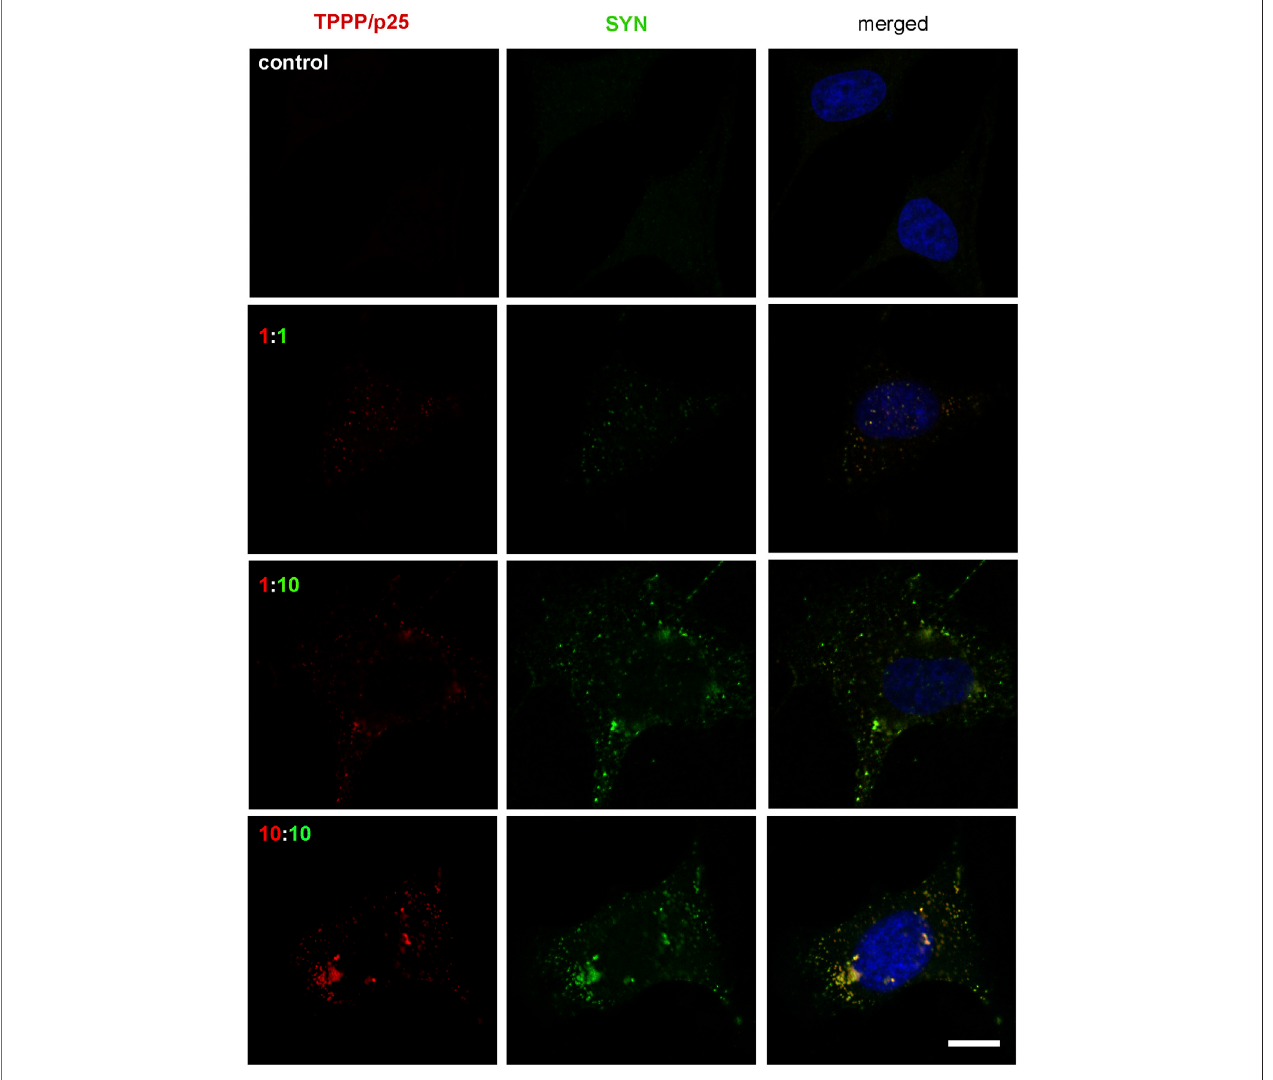
FIGURE4| VisualizationoftheassemblyofSYN(green)andTPPP/p25(red)by fl uorescenceconfocalmicroscopyatdifferentratiosandconcentrationsofproteins inpre-starvedHeLacells.Proteinswereaddedtothemedium ofcells,incubation timewas4 h. The1:1equimolar concentration correspondsto80 nM.Representative images were evaluated by speci fi c TPPP/p25 and SYN antibodies. Nuclei were counterstained with DAPI (blue). Scale bar: 5 μ m.